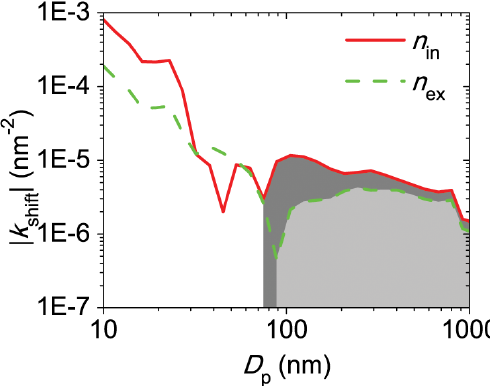
Fig. 7. The size dependence of the particle size distribution n(D p ) variation due to condensation growth. k shift equals (∂n/∂t)/n due to condensation growth divided by a constant (in Eq. 20). k shift can ei- ther be positive or negative, which indicates increases and decreases of n(D p ) due to condensation growth, respectively. The shaded ar- eas (with gray and light gray for n in and n ex , respectively) indicate the size ranges where k shift are positive while k shift are negative in the un-shaded